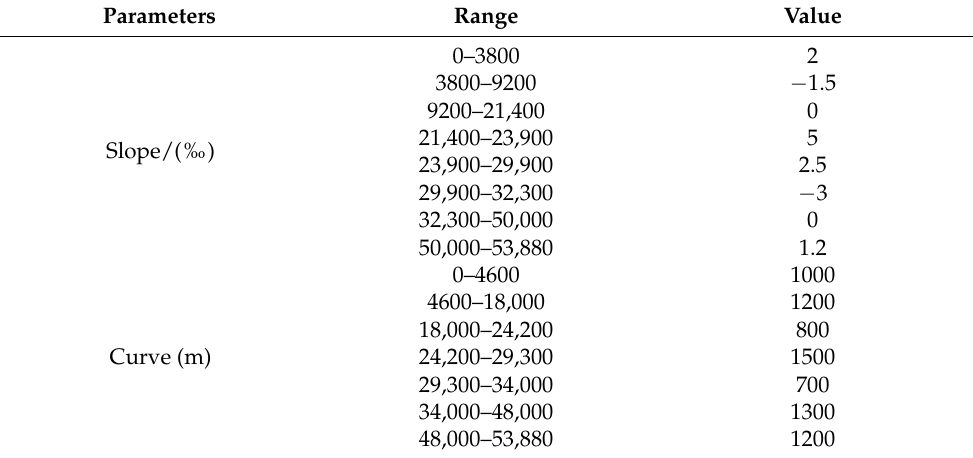
Table 1. Parameters for route